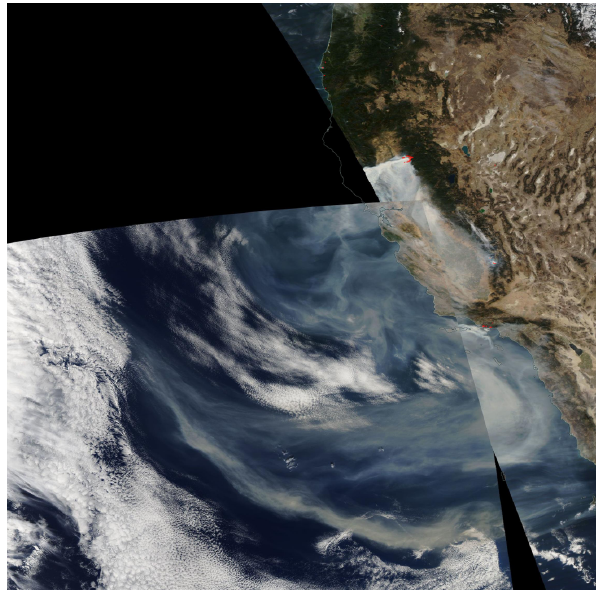
Figure A4. Smoke plume captured by Aqua MODIS for the Califor- nian fire event on 11 November 2018 (source: https://gibs.earthdata. nasa.gov, last access: 7 August 2019). The red regions indicate fires and thermal anomalies.